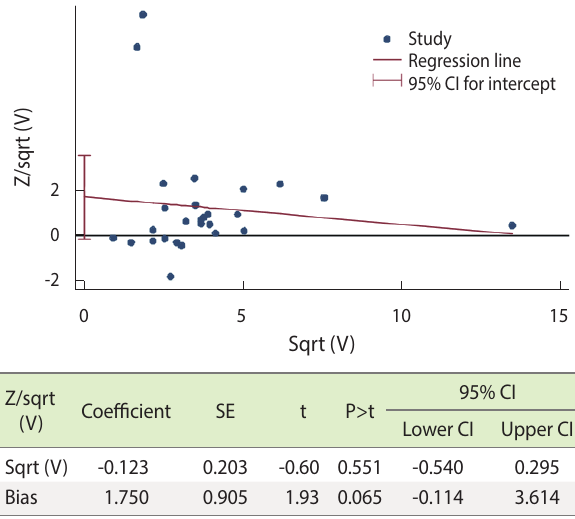
Figure 7. Harbord’s modified test and modified Gilbert’s plot for the small-study effect. Z, efficient score; V, scored variance; SE, standard error; CI, confidence